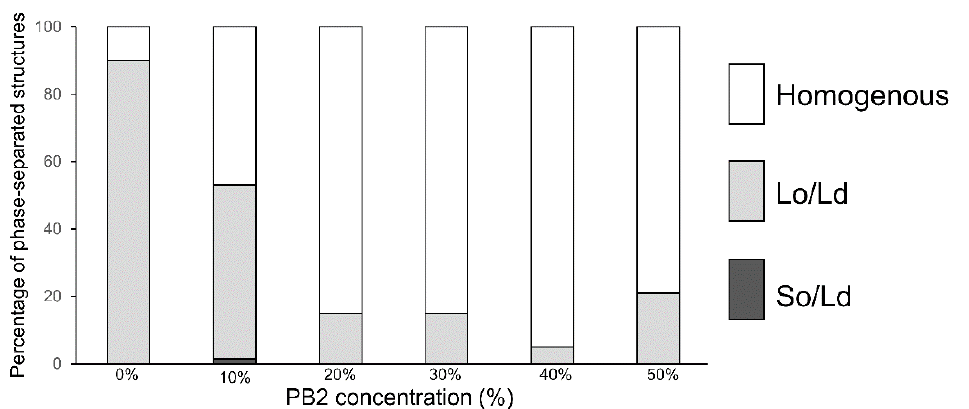
Figure 1. Microscopic images of multicomponent liposomes. Homogeneous (Ld) phase (DOPC/DPPC 50:50, ( A ), Lo/Ld phase separation (DOPC/DPPC/Chol 40:40:20, ( B ), and So/Ld phase separation (DOPC/DPPC 50:50, ( C ). Bright regions indicate the Ld phase ( A – C ), and dark regions indicate the So and Lo phases in ( B , C ), respectively. The Ld phase was labeled with a fluorescent dye (Rhodamine-DHPE). Rhodamine DHPE should be almost entirely distributed throughout the Ld phase [44].